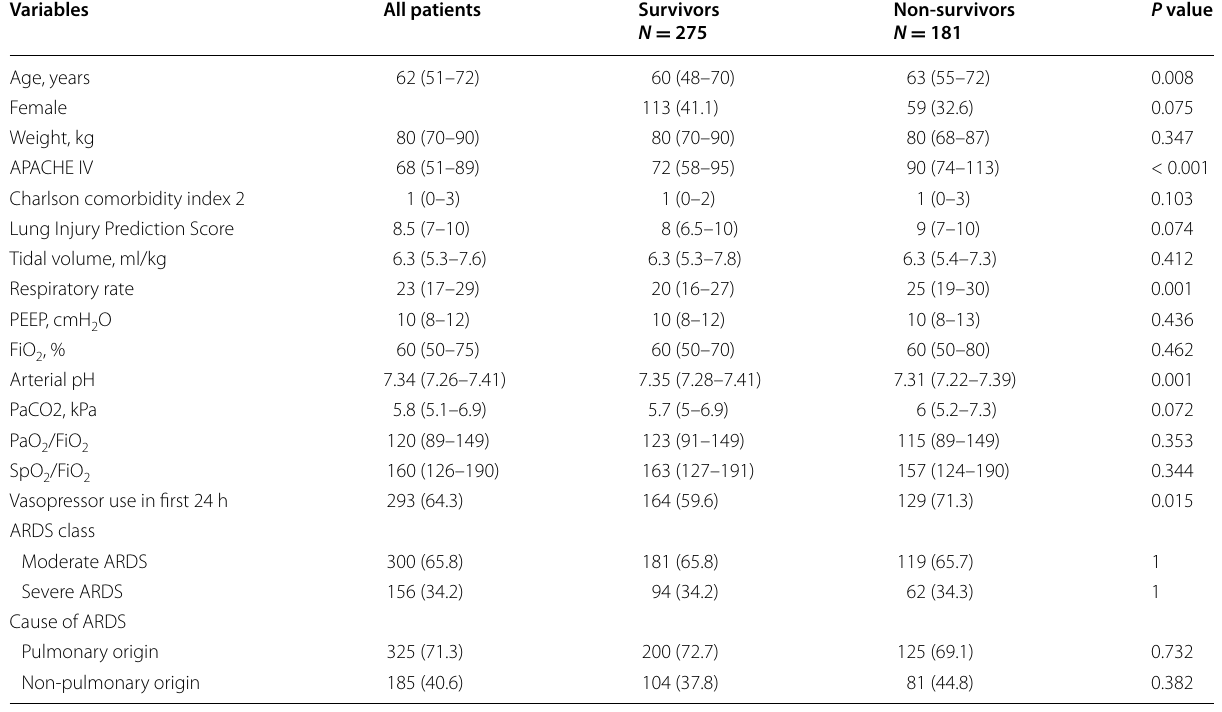
Categorical variables: number (percentage); continuous variables: median (25–75 percentile)